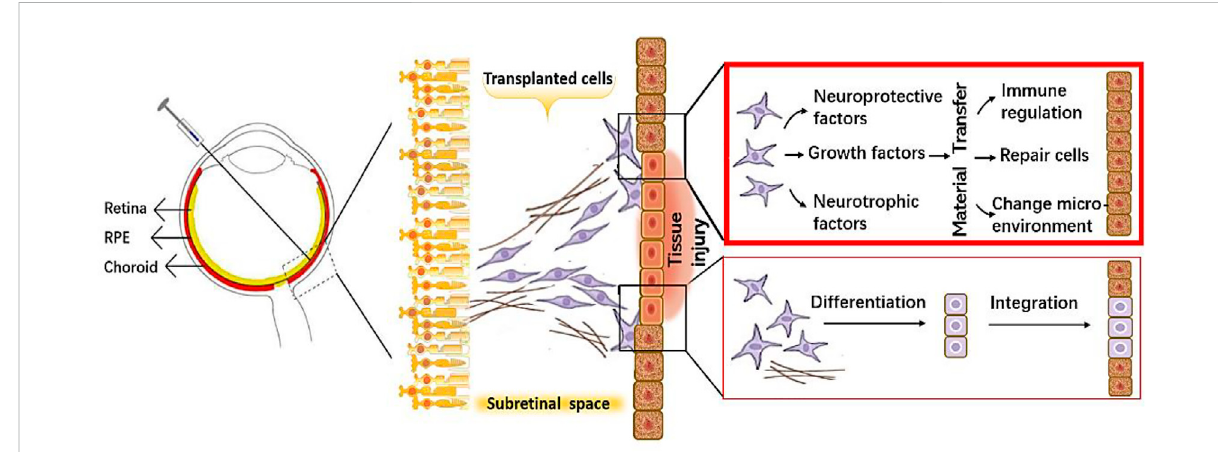
FIGURE 1 A schematic diagram showing protective mechanisms of the transplanted cells on retinal